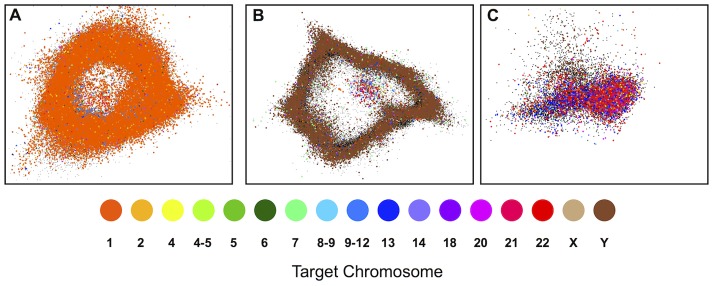
Reads from flow-sorted chromosomes are useful in assigning genome-wide distributions of HSat2,3 subfamilies.Read feature vectors from flow-sorted chromosome datasets (colored according to targeted chromosome(s)) are overlaid on PCA projections of the read databases (colored black) for (A) HSat2A2, (B) HSat3A6, and (C) HSat3A4. The plots qualitatively show enrichment for chromosomes 1, Y, and the acrocentrics, respectively. This enrichment is quantitatively and precisely measured in order to infer the chromosomal localization of each subfamily (see Methods).